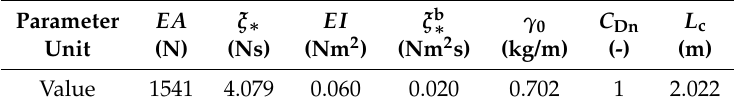
Table 2. Data used in the baseline simulation of Koh’s experiment, computed from ρ = 1430 kg/m 3 and E = 3.14 MPa [28]. The simulated length ( L c ) is the length between the two pins (the pivot pin and the release pin), thus neglecting the 12 mm extra cable at each end. Parameter EA ξ ∗ EI ξ b ∗ γ 0 C Dn L c Unit (N)